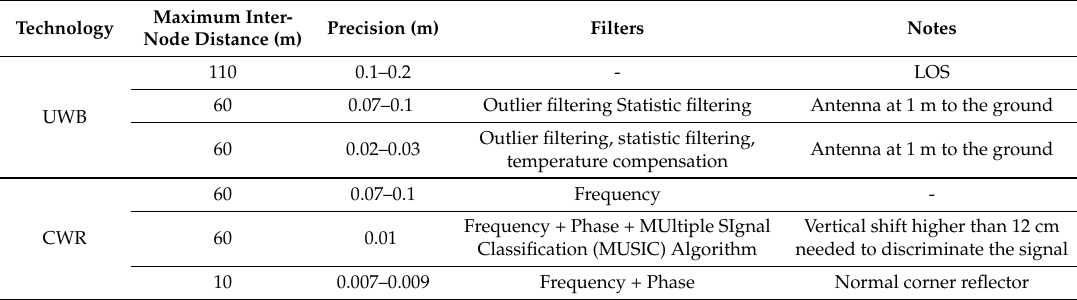
Table 3. UWB and CWR max distance between nodes and